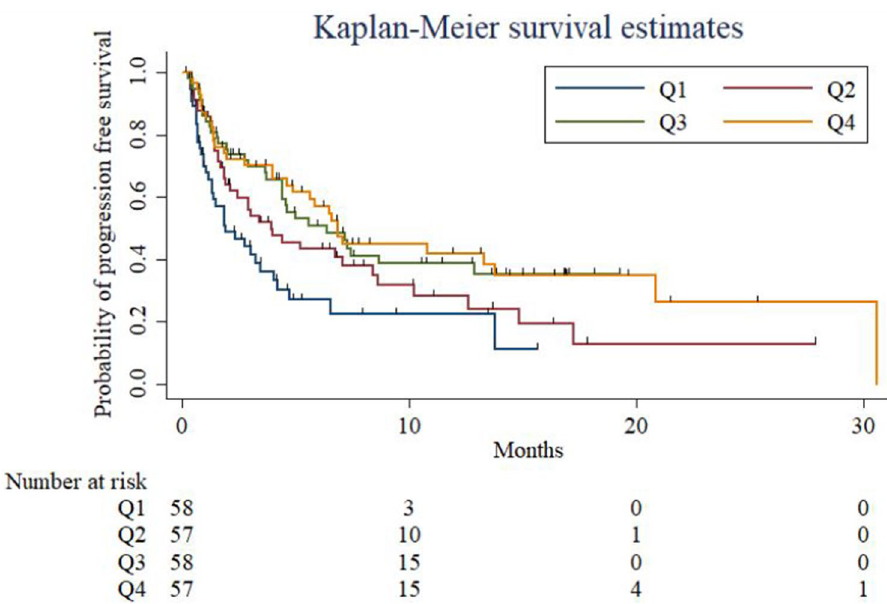
Figure 1. Kaplan–Meier curves showing progression-free survival (PFS) stratified by quartiles of post- treatment